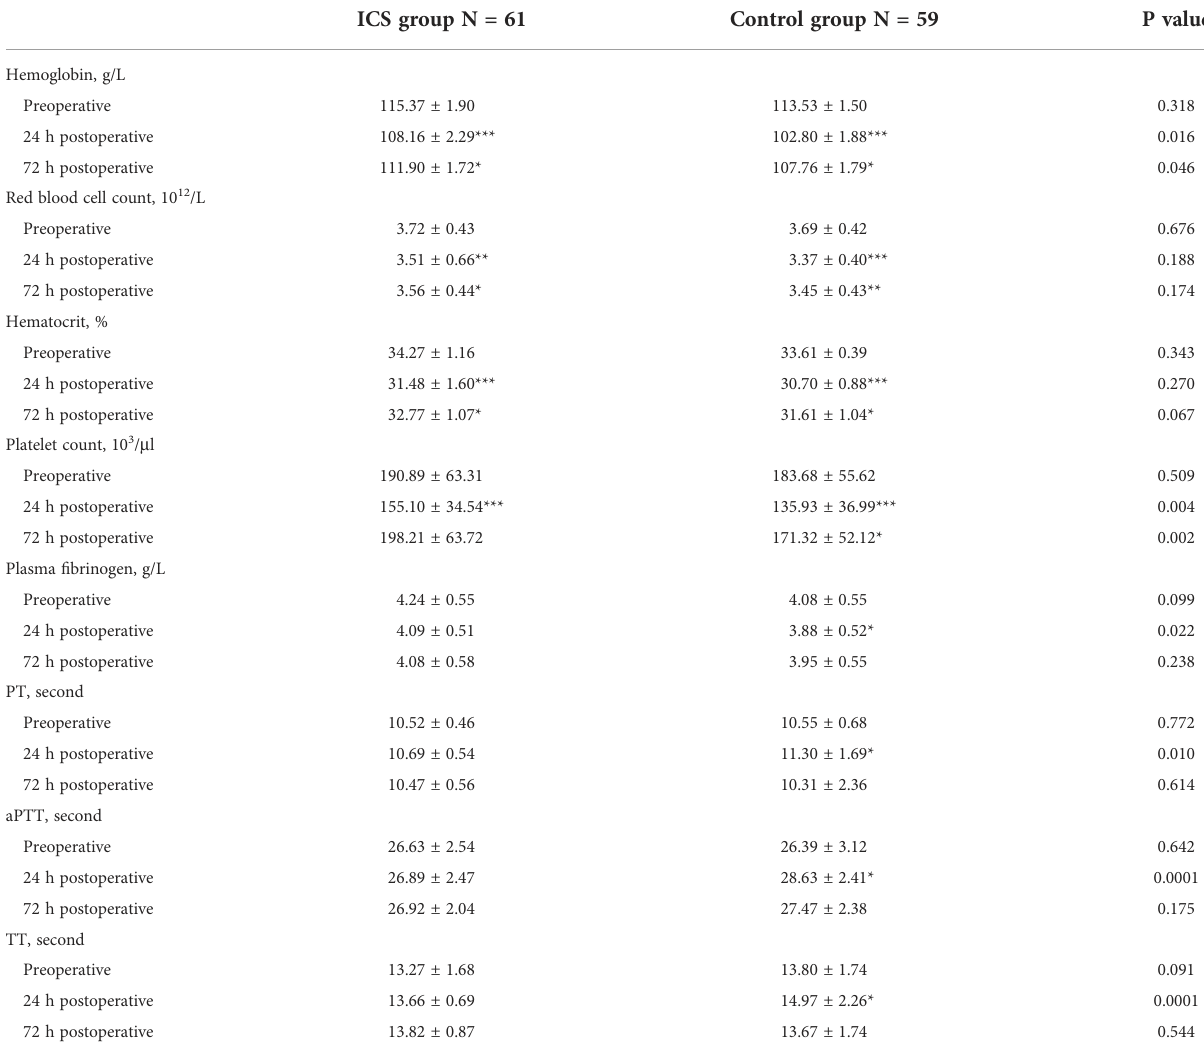
TABLE 2 Comparison of perioperative blood count and coagulation function between the two groups. ICS group N =